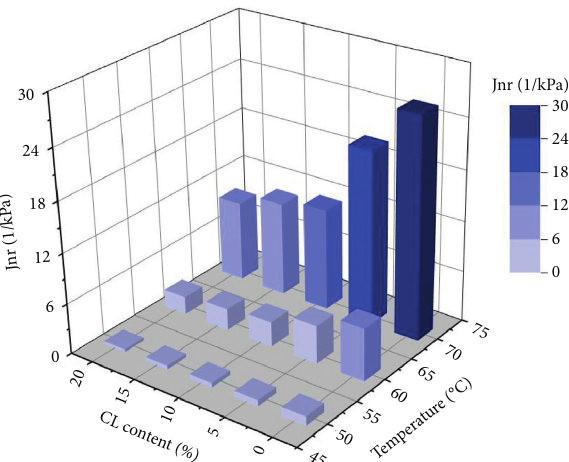
Figure 10: Variations in the nonrecoverable creep compliance ( J